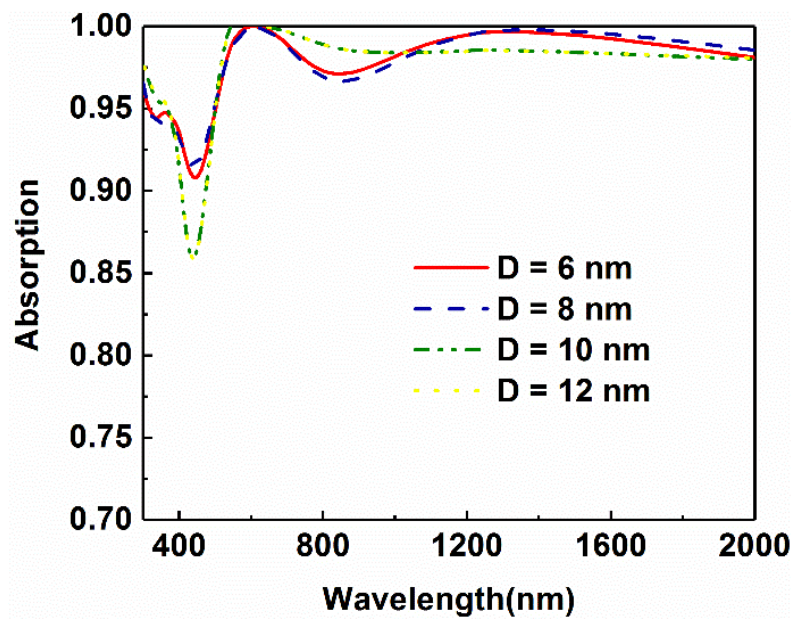
Figure 6. Comparison of light absorption of the absorbers with different Ti thicknesses in the bottom multilayer.